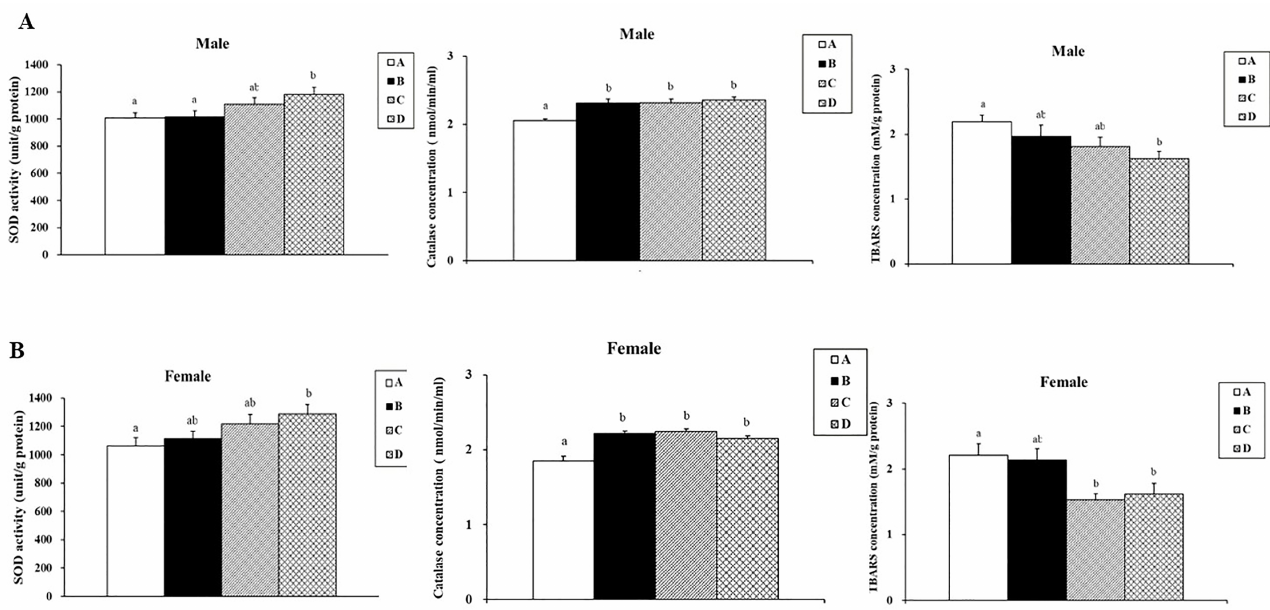
Figure 1. Effects of SPE treatment on SOD activities, catalase activities, and LPO in brain tissues of SAMP8 mice. ( A ) Male SAMP8 mice. ( B ) Female SAMP8 mice. Data are expressed as the mean ± SEM and analyzed by one-way ANOVA. Groups with different letters indicate significant differences among each group ( p <